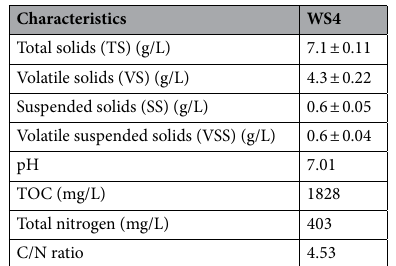
Table 1. Characteristic of WS4. Data show mean ± standard deviation (n = 3).